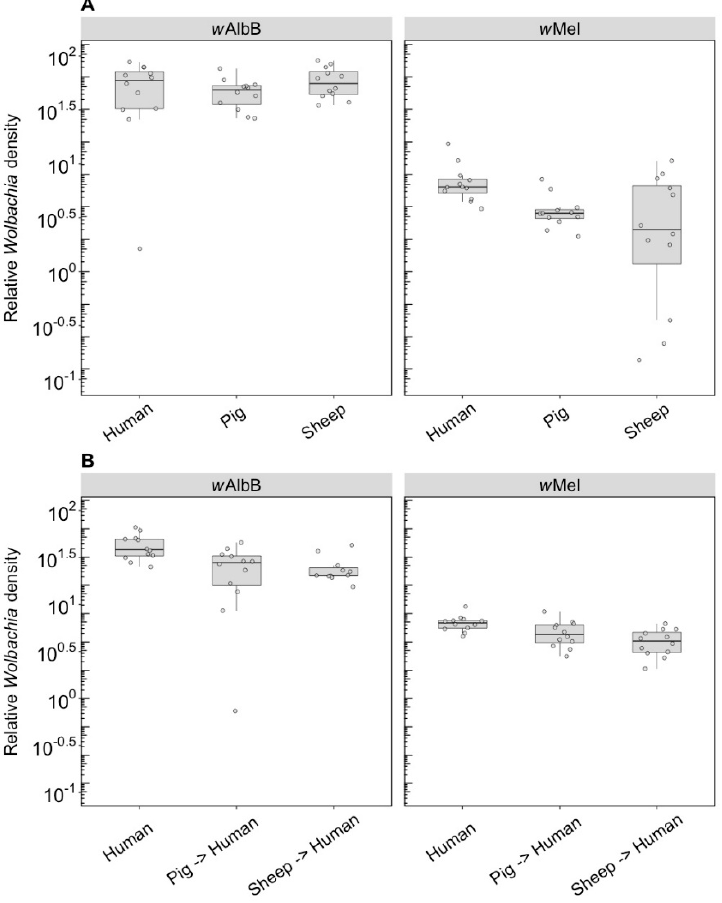
Figure 3. Comparison of the relative Wolbachia density of the infections types ( w Mel, w AlbB) across different blood sources (human, pig, sheep). ( A ) Relative Wolbachia density of parents fed on different blood sources; ( B ) relative Wolbachia density of F1s after being re-introduced to human blood. Each dot represents the density of an individual mosquito. The boxplots represent the first to the third quartiles around the median (horizontal grey line) and the vertical bars represent the 1.5 interquartile of the lower and upper quartiles. Around 12 individuals per blood source and infection type were tested from the parental and F1 generations.